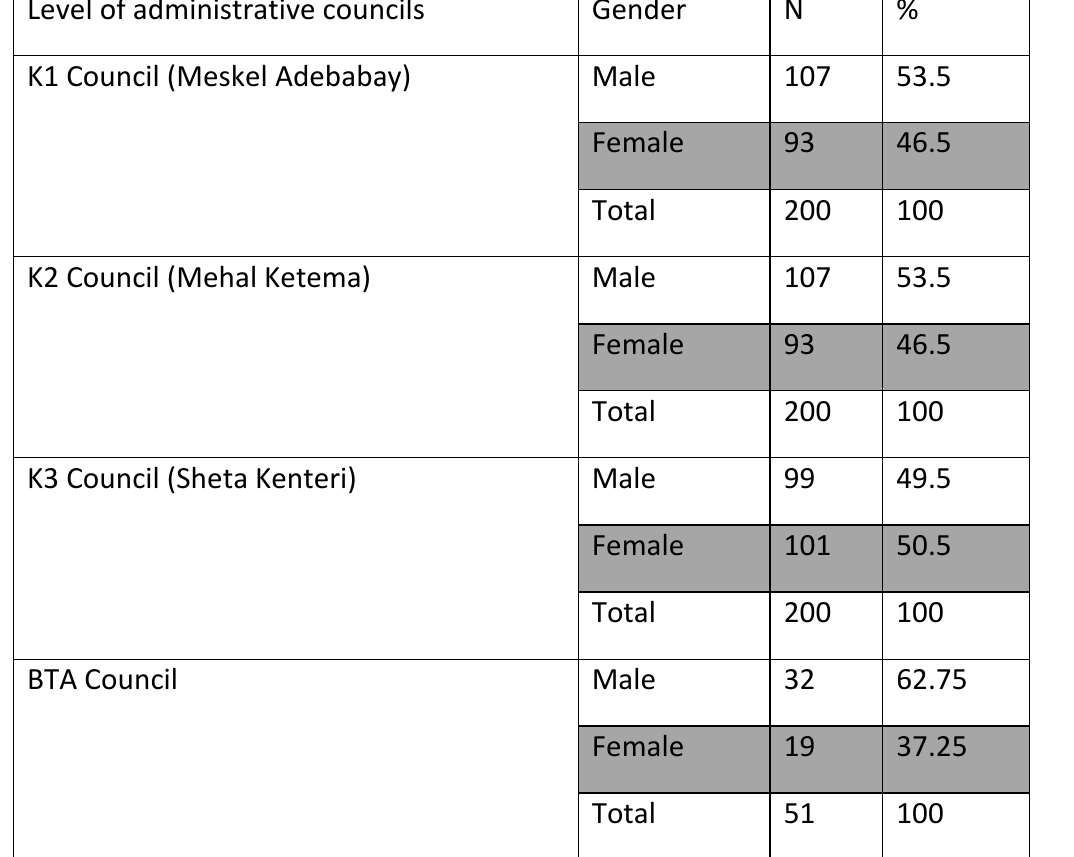
Table 13: Proportion of women representatives in administrative councils of the town Level of administrative